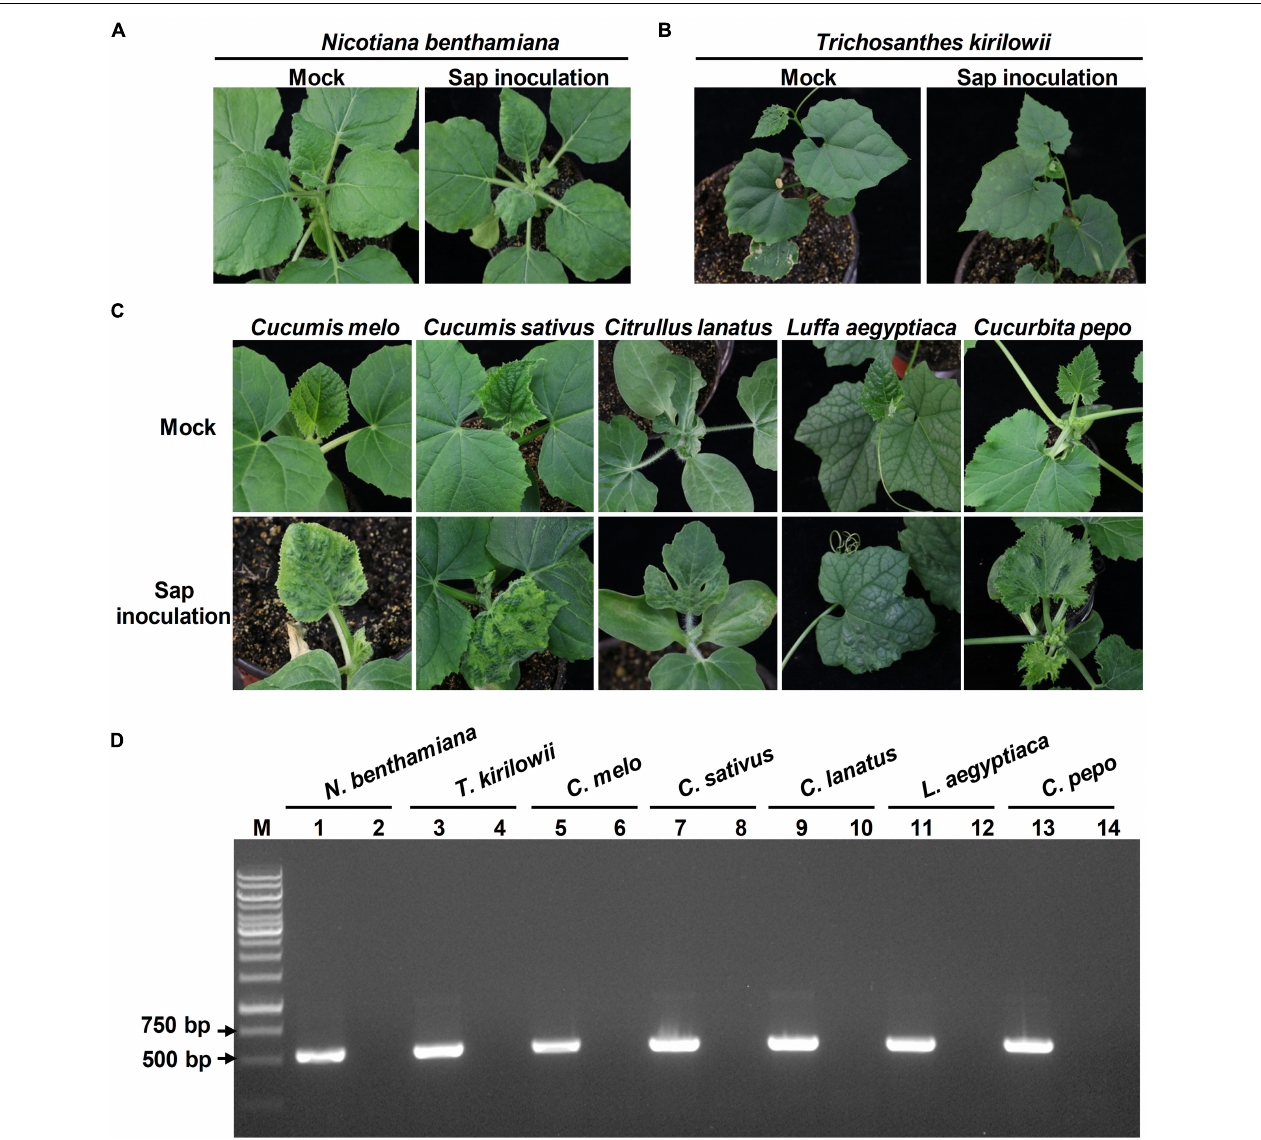
FIGURE 6 | Pathogenicity of TrMMV to Nicotiana benthamiana , Trichosanthes kirilowii , and five cucurbitaceous crops based on mechanical inoculation. TrMMV-infected N. benthamiana plants (previously agroinfiltrated with the TrMMV infectious clone) were used as inoculum for sap inoculation. Mock plants were rub-inoculated with PBS buffer. (A) Mechanical inoculation phenotype of N. benthamiana. (B) Phenotypes of T. kirilowii at 10 days after mechanical inoculation. (C) Phenotypes of Cucumis melo , C. sativus , C. lanatus , Luffa aegyptiaca , and Cucurbita pepo plants infected by sap inoculation at 12 dpi. (D) RT-PCR detection of TrMMV in systemic leaves of rub-inoculated plants using TrMMV-specific primers. Lane M, GeneRuler 1 kb DNA ladders (Thermo); lane 1, 3, 5, 7, 9, 11, 13, samples collected from systemic leaves of mechanically inoculated N. benthamiana , T. kirilowii , C. melo , C. sativus , C. lanatus , L. aegyptiaca , and C. pepo plants, respectively; lanes 2, 4, 6, 8, 10, 12, 14, samples mock-inoculated with PBS